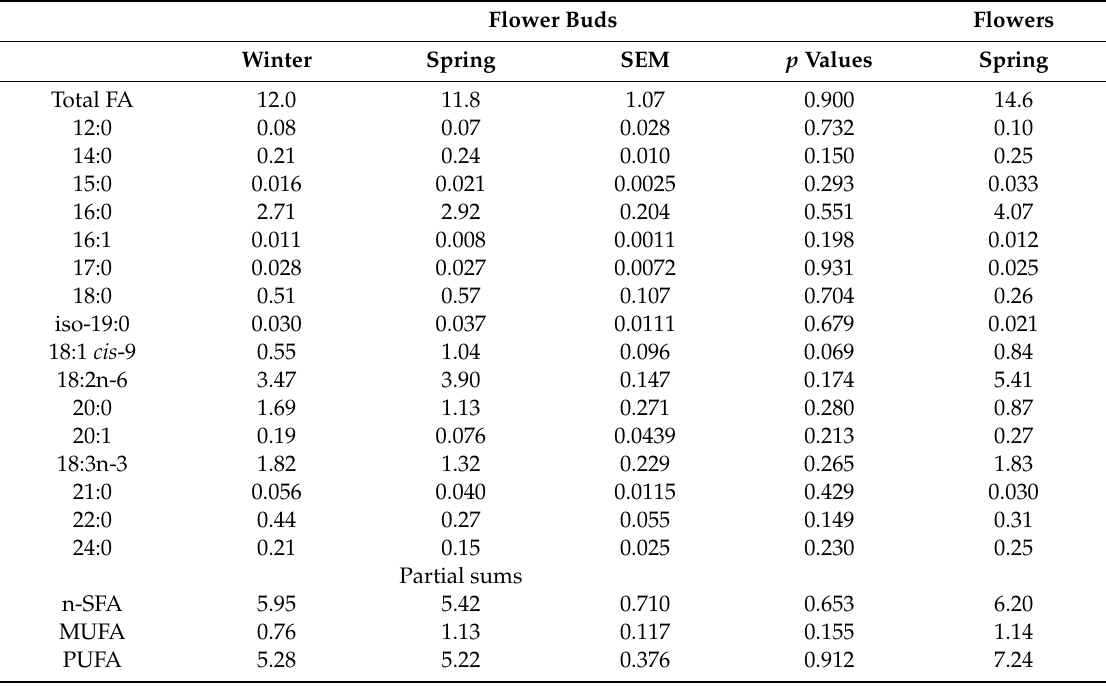
Table 3. E ff ect of season on fatty acid composition (mg / g DM) of C. ladanifer flower buds and flowers. Flower Buds Flowers Winter Spring p Values Spring